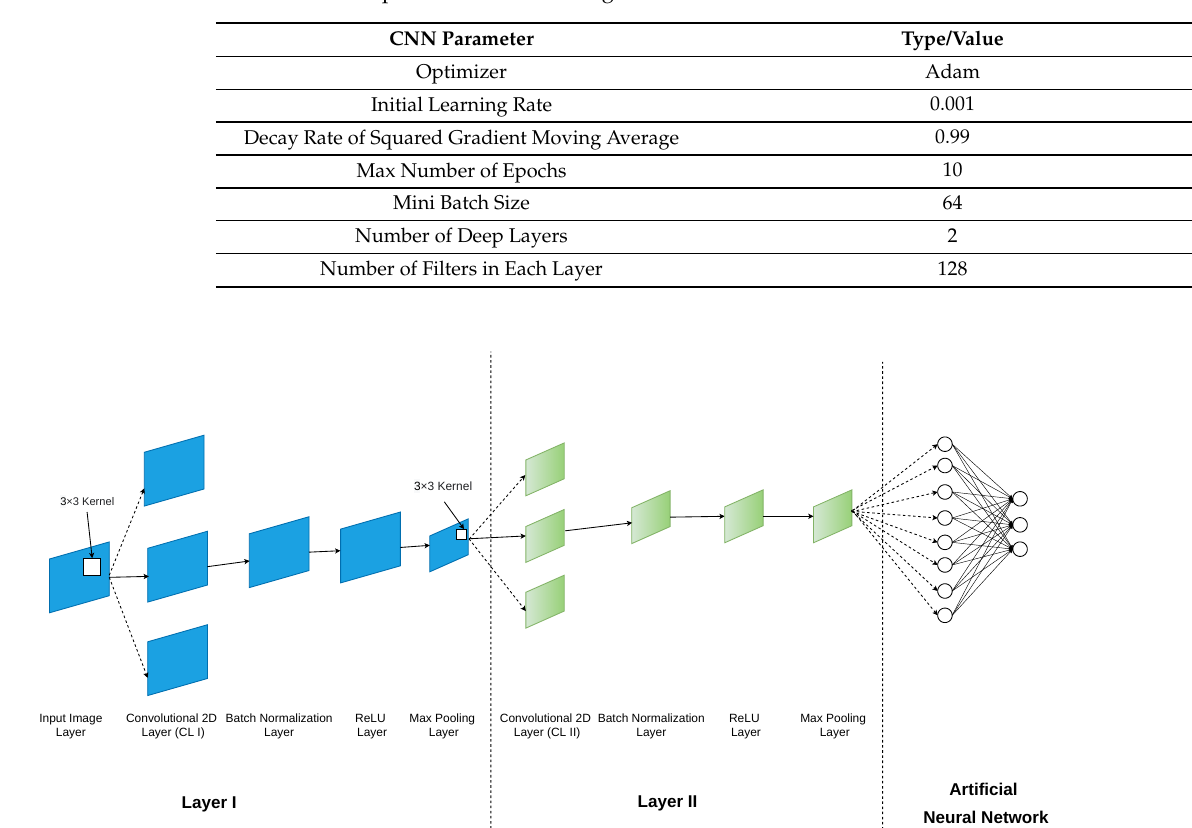
Table 2. Various parameters of the designed CNN.